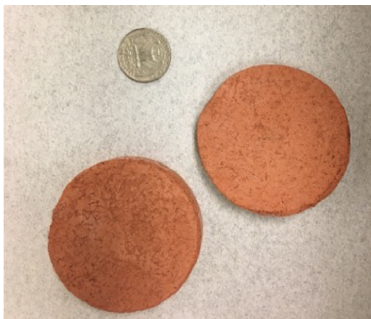
Figure 1: Ceramic filter disks used for laboratory